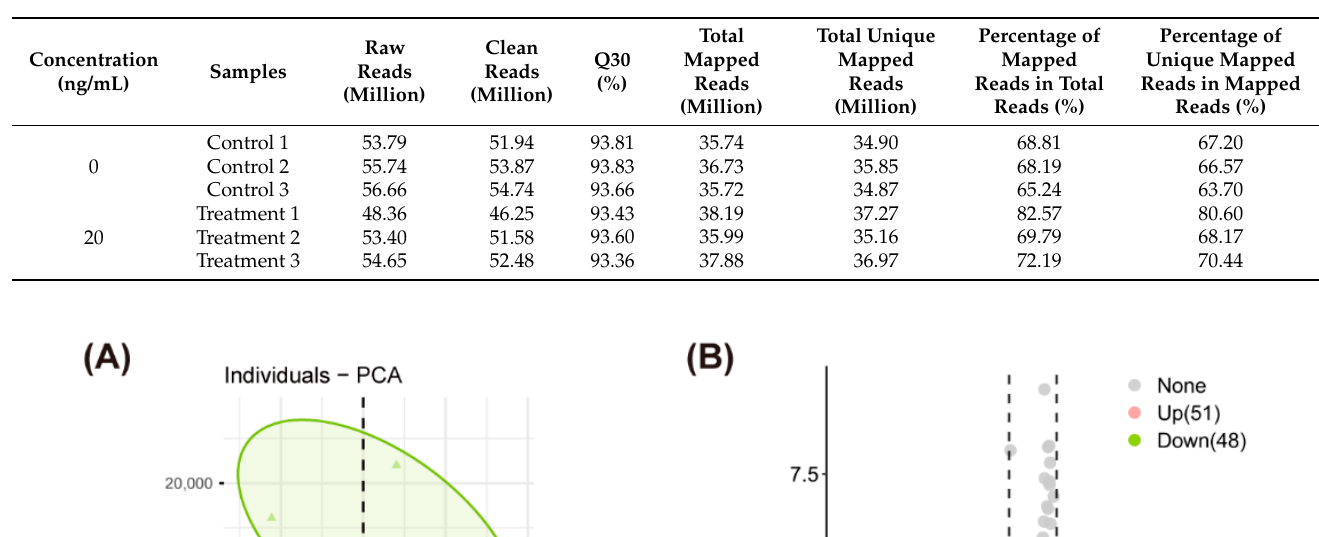
genes between two groups.